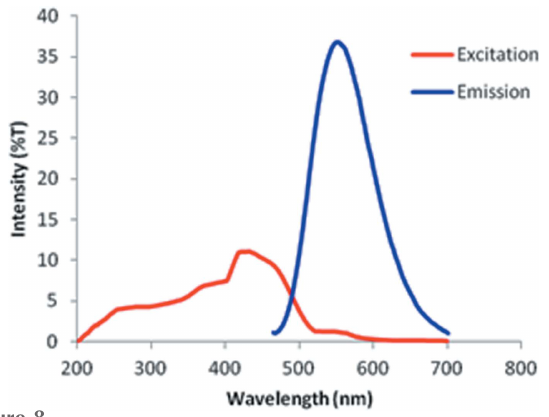
Figure 8 Solid-state excitation and emission spectrum for the title